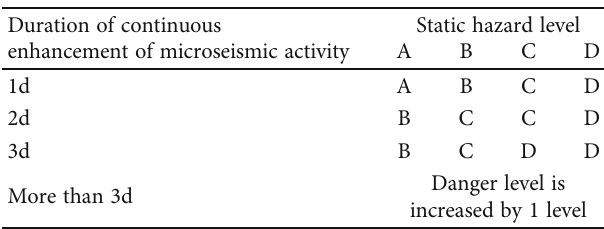
Table 2: Dynamic evaluation method of AE-EME-MS coupling